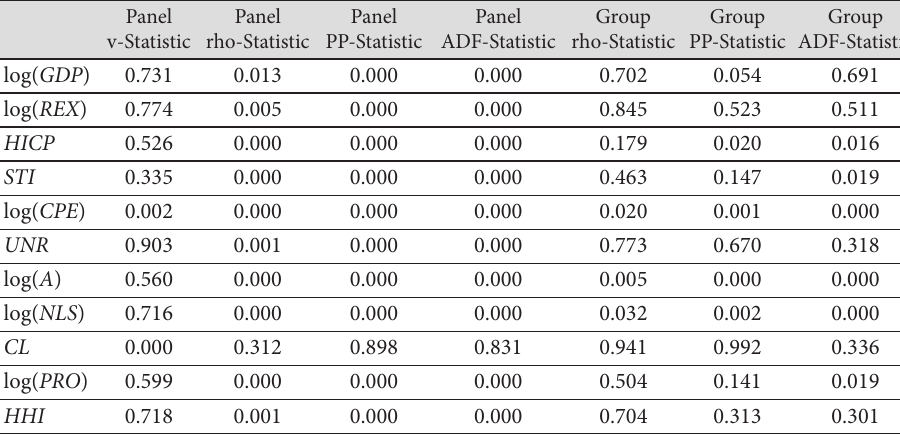
Table 9. Panel co-integration tests (net interest income)